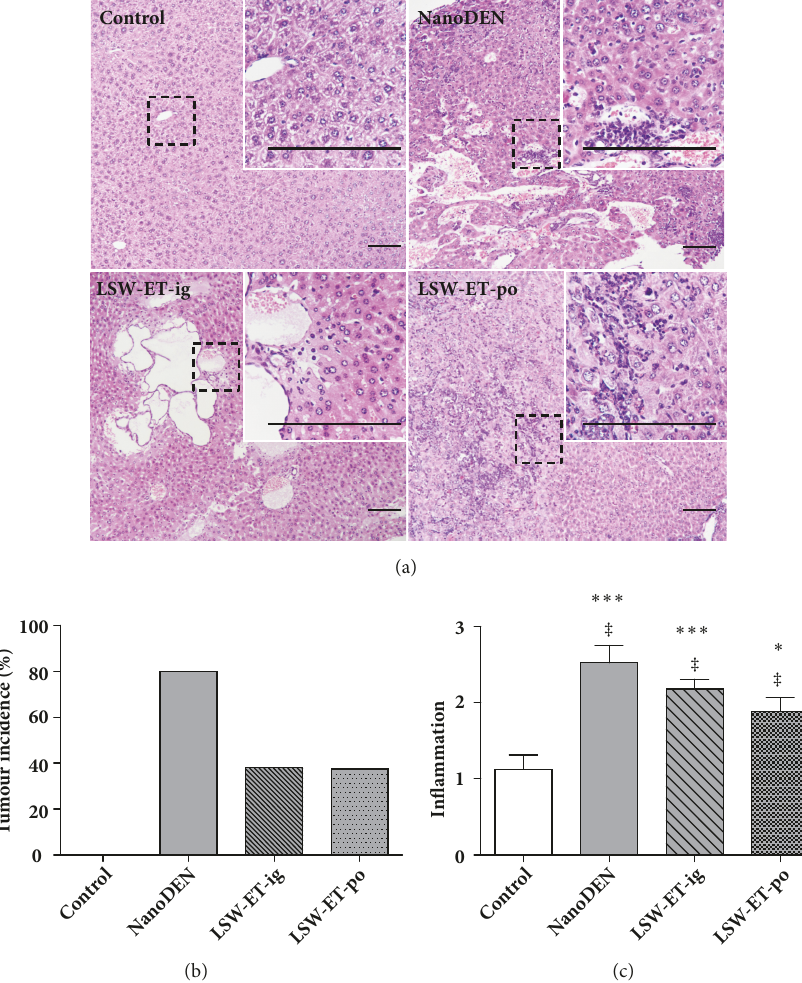
Figure 3: The anticancer efficacy of different administration of L S W-ET in nano D EN-induced HCC in mice. (a) Histological analysis of livers from the control group, nanoDEN group, LSW-ET-ig, and LSW-ET-po group at the 30th week. Histological analysis of the livers was performed by hematoxylin and eosin staining. Part of the arbor (stippled outline, 100 × ) is shown enlarged in the inset (400 × ) in the top right corner. Scale bar, 50 휇 m. (b) The probability of occurrence of tumor in each group. (c) Scores of inflammation of liver samples. ∗ and ∗ ∗ ∗ , P < 0.05 and 0.001, respectively, compared with the control group; ‡ , P > 0.01 compared with the nanoDEN